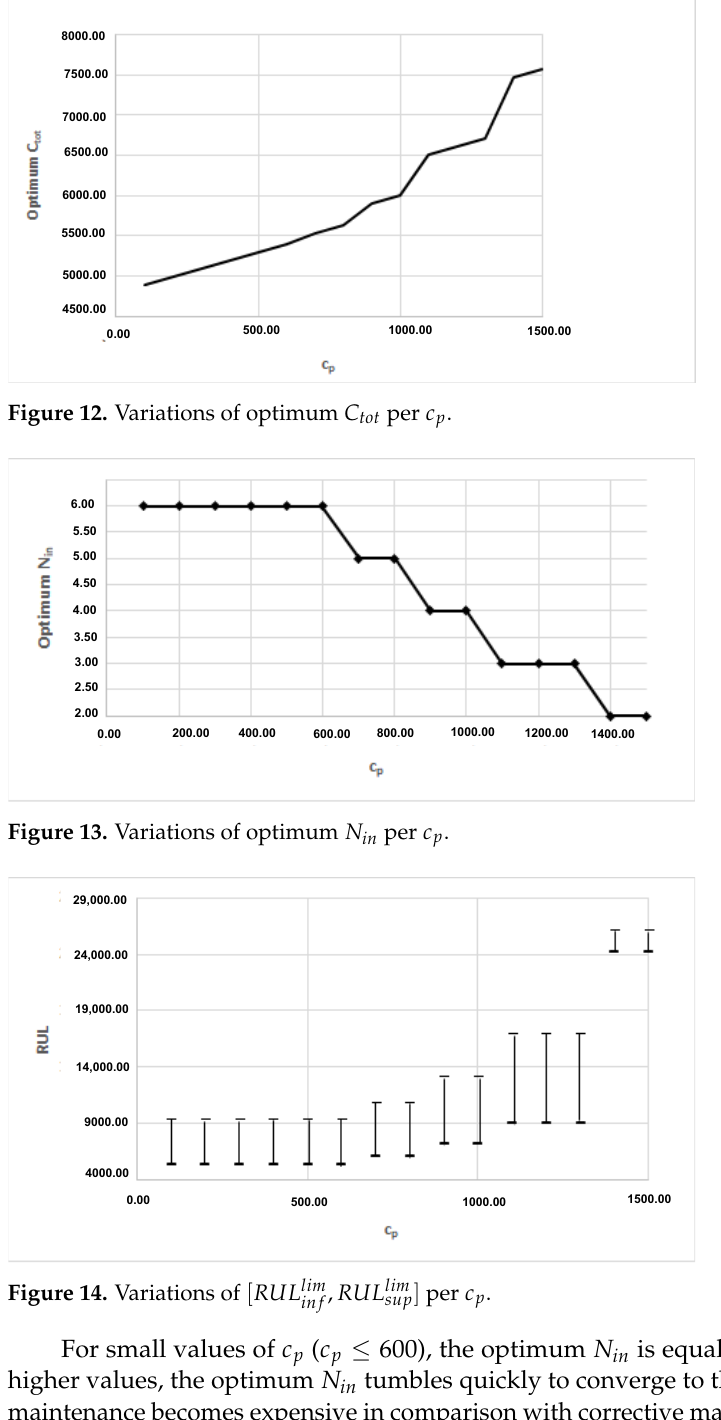
, RUL lim sup ] per c p inf